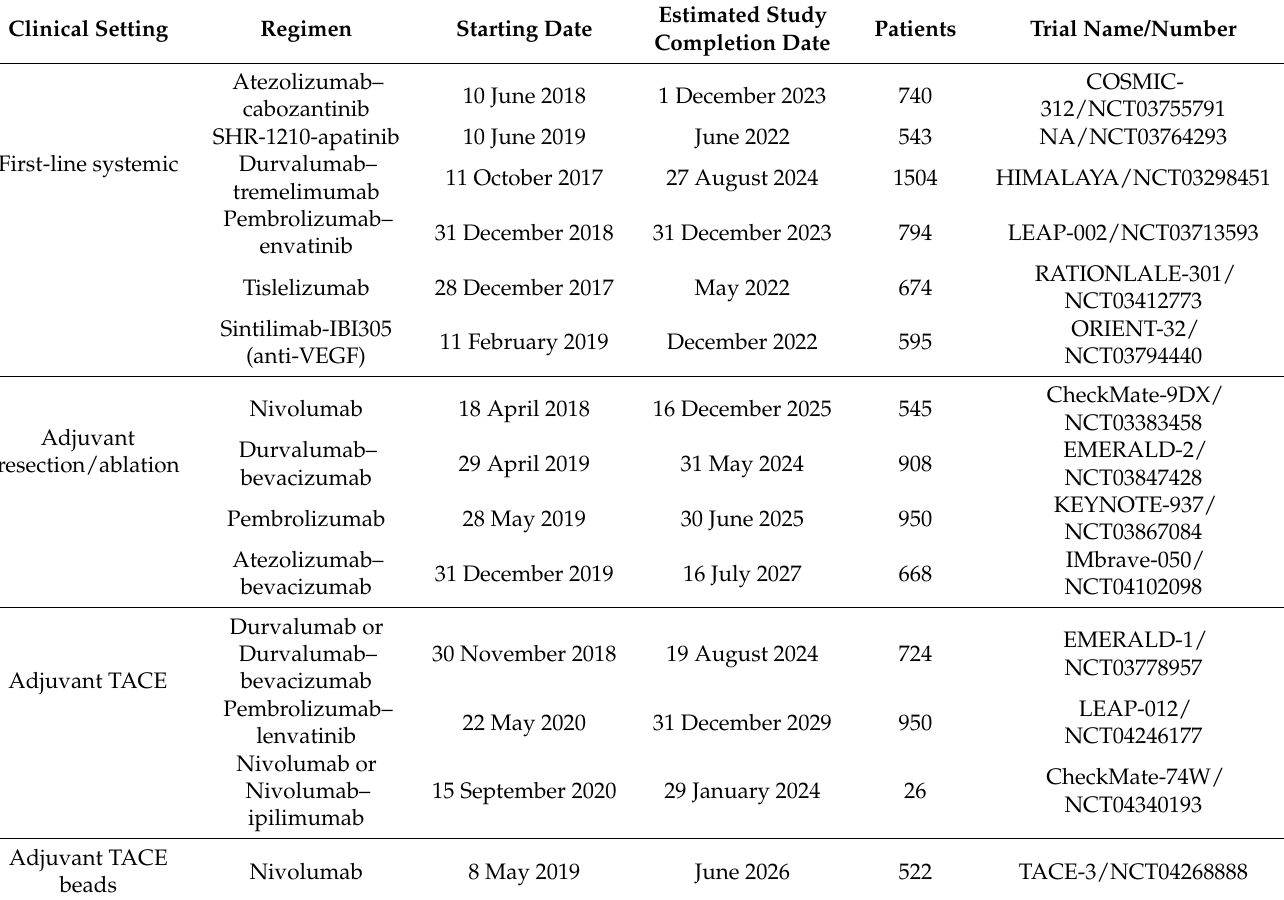
Table 4. Phase III clinical trials of immune checkpoint inhibitors for